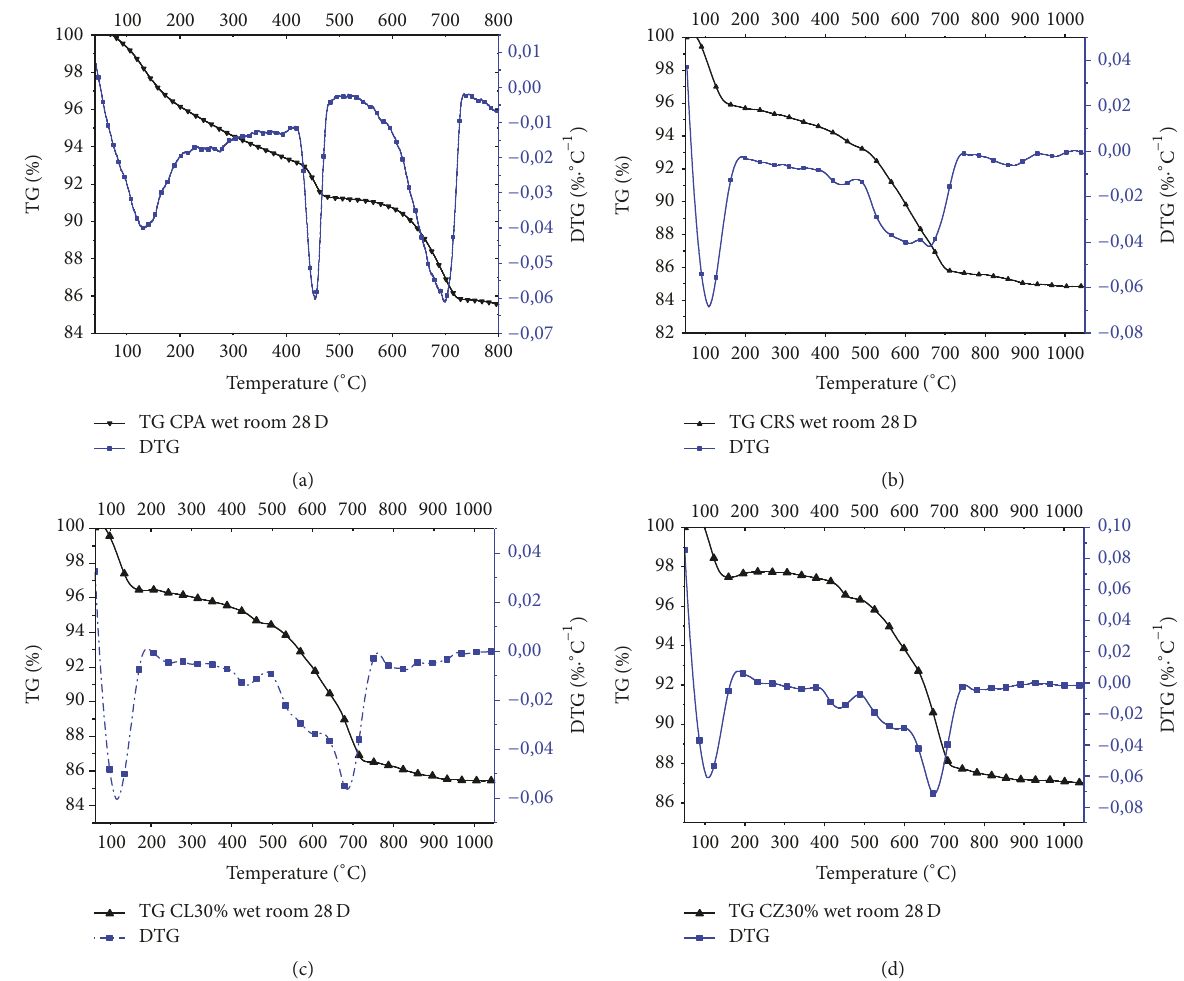
Figure 7: DTG/TG cement paste preserved in wet cure (RH = 95%, 𝑇 = 20 ∘ C) for 28 days: (a) CPA, (b) CRS, (c) CL30% (30% slag), and (d) CZ3% (30% pozzolana).